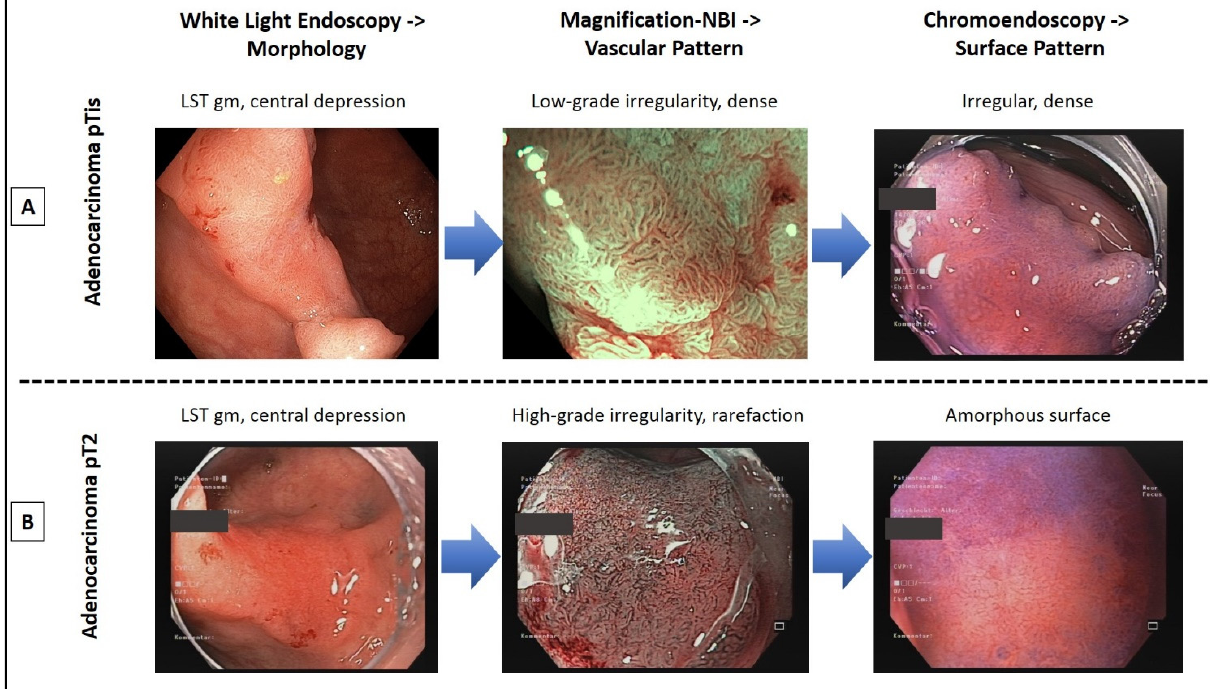
Figure 5. Endoscopic optical characterization of two large colonic lateral spreading tumors of the granular mixed type (LST gm). Magnification endoscopy with narrow band imaging (NBI) and chromoendoscopy with crystal violet allow for differentiation between early adenocarcinoma, which can be curatively resected by endoscopic submucosal dissection ( A ) and invasive carcinoma, requiring oncologic surgery ( B ).